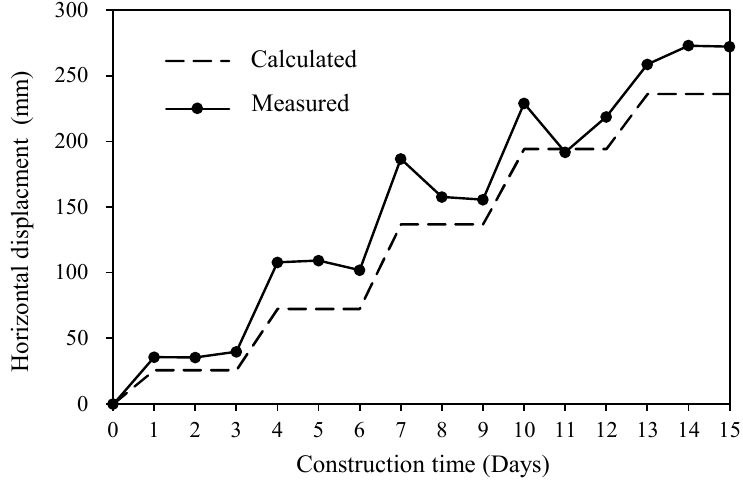
Figure 5. The comparison of the measured and calculated horizontal displacement of the pile at the ground surface.